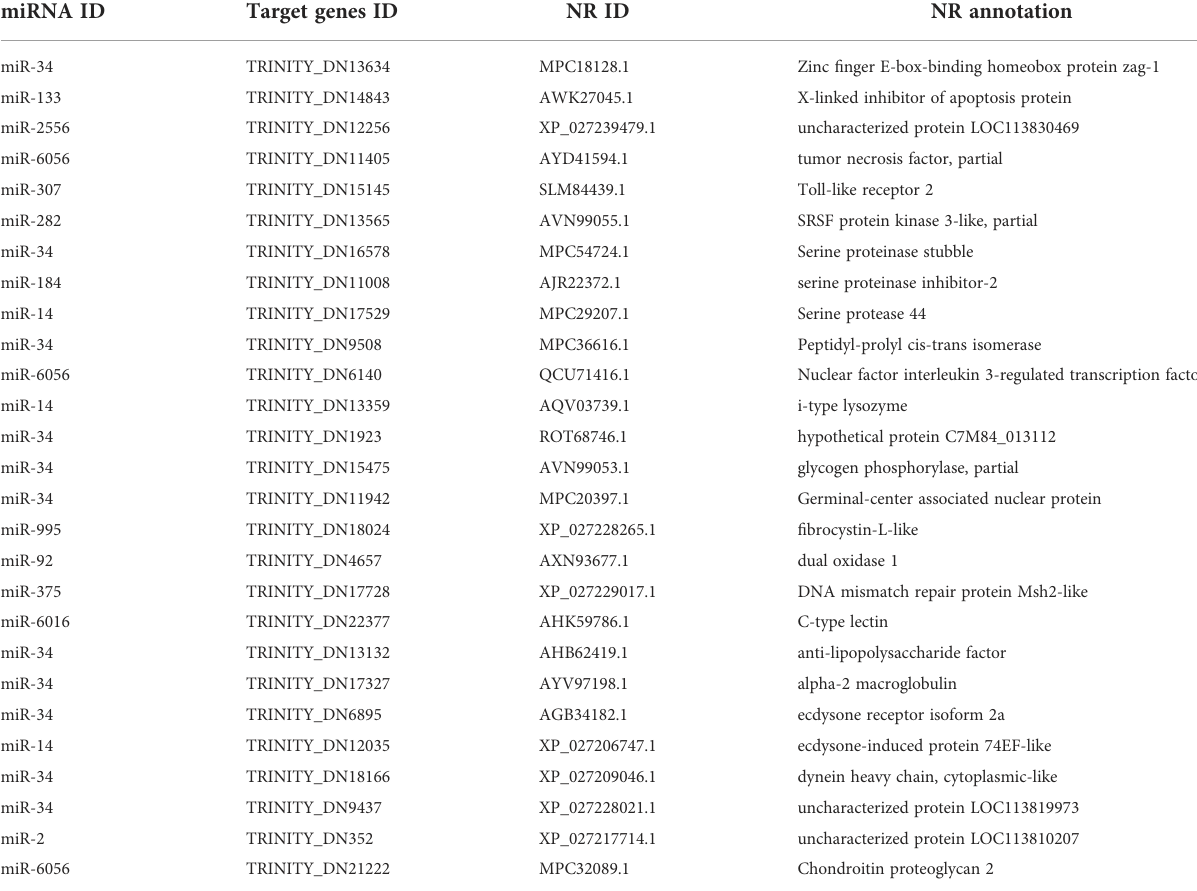
TABLE 1 EVs miRNAs with putative target genes in relation to innate immune response, ecdysteroid hormone receptor activity, and chitin-based cuticle development. miRNA ID Target genes